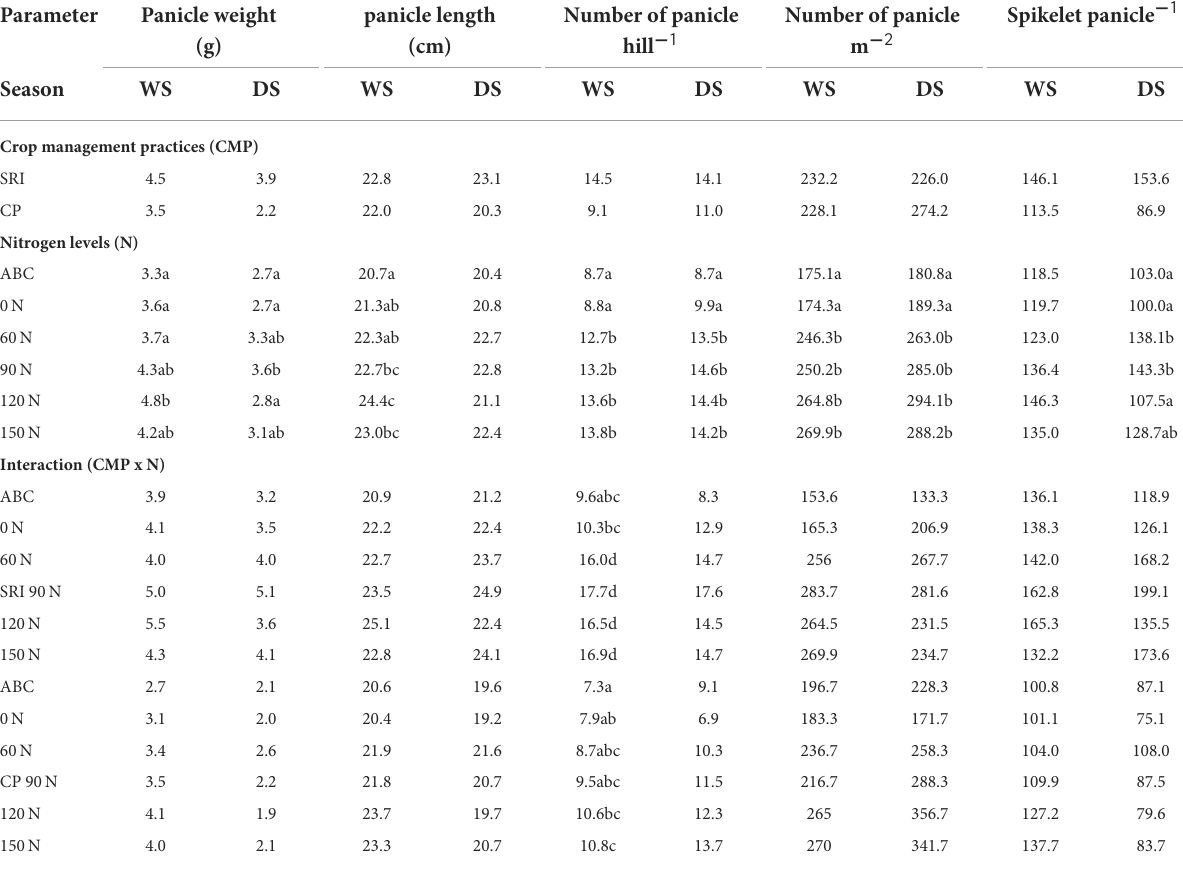
TABLE 12 Effects of crop management practices and fertilizer N levels on panicle components of rice.